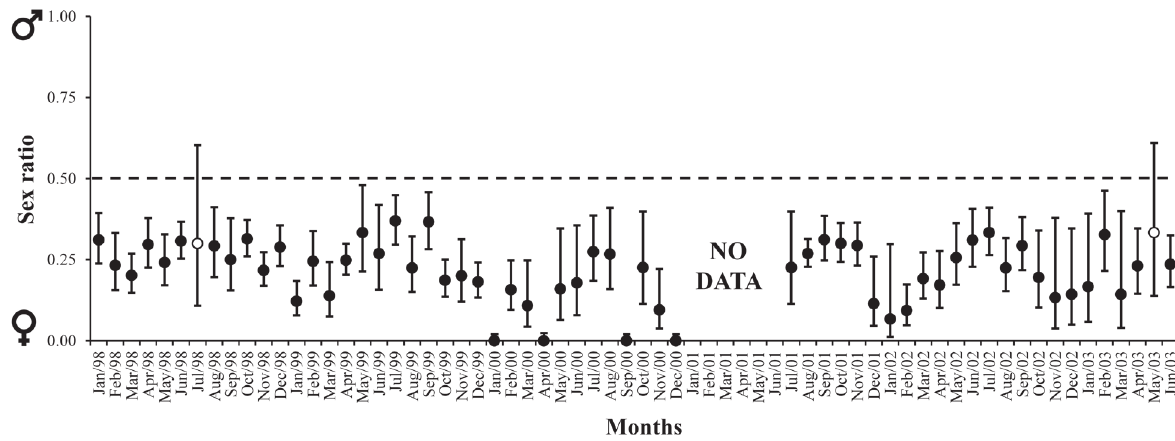
Figure 2 - Rimapenaeus constrictus . Monthly sex ratio (estimate ± standard error) for samples from January 1998 to June 2003 from the northern littoral of São Paulo state. Black circles indicate a significant deviation from a 1:1 (M:F) sex ratio (binomial test,